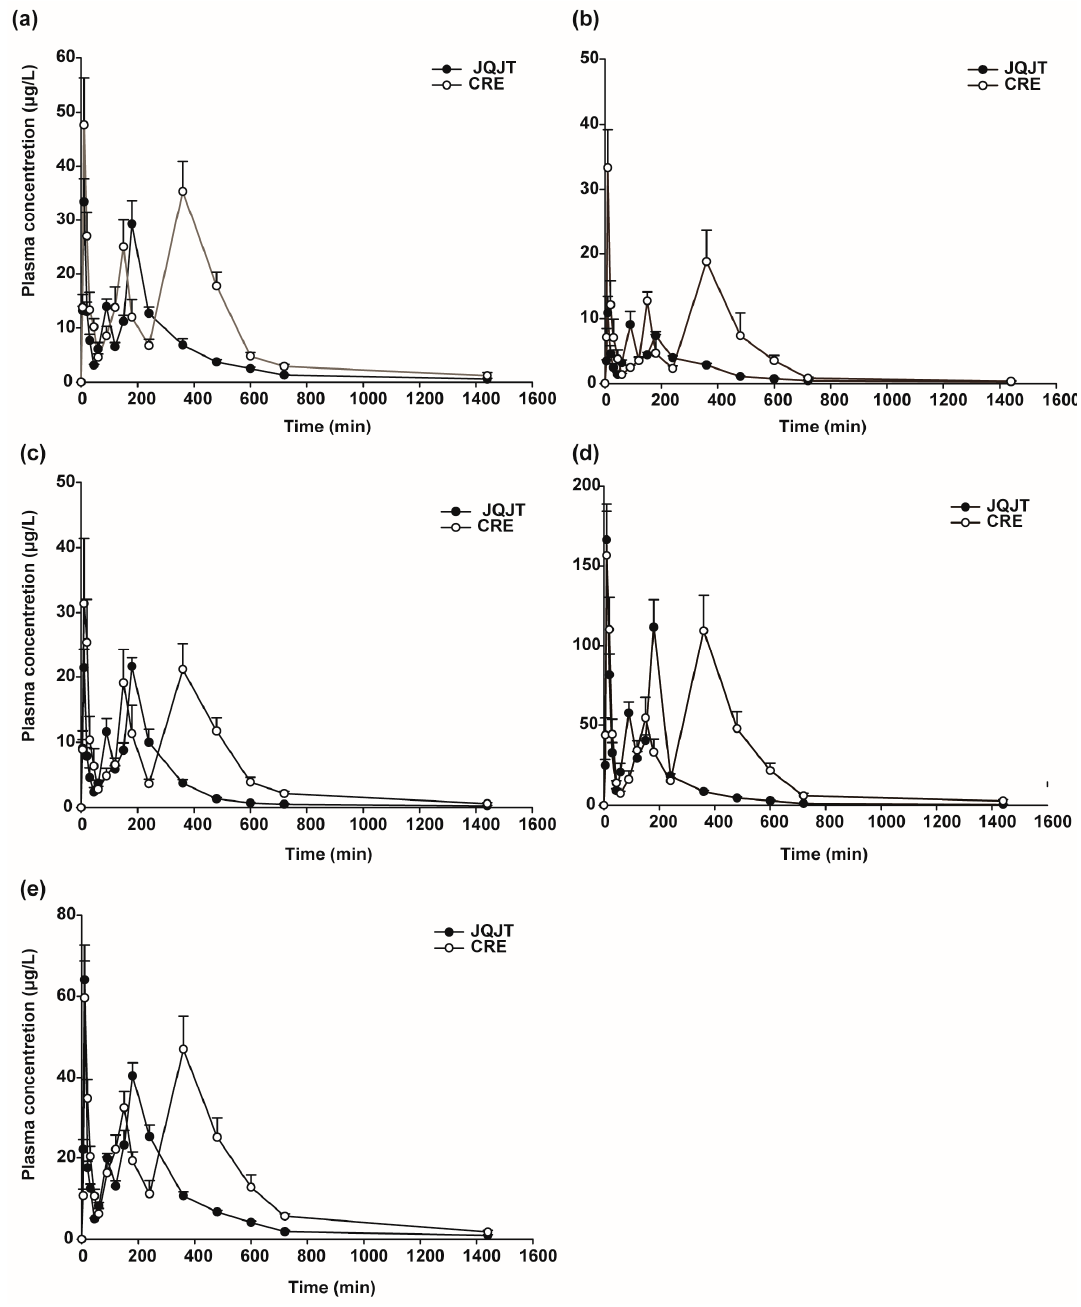
Figure 4. Mean plasma concentration-time profiles of palmatine chloride ( a ), jatrorrhizine chloride ( b ), epiberberine chloride ( c ), berberine chloride ( d ), and coptisine chloride ( e ) in rat plasma after oral administration of JQJT tablets and CRE. The error bars represent the standard deviation obtained from six replicates.